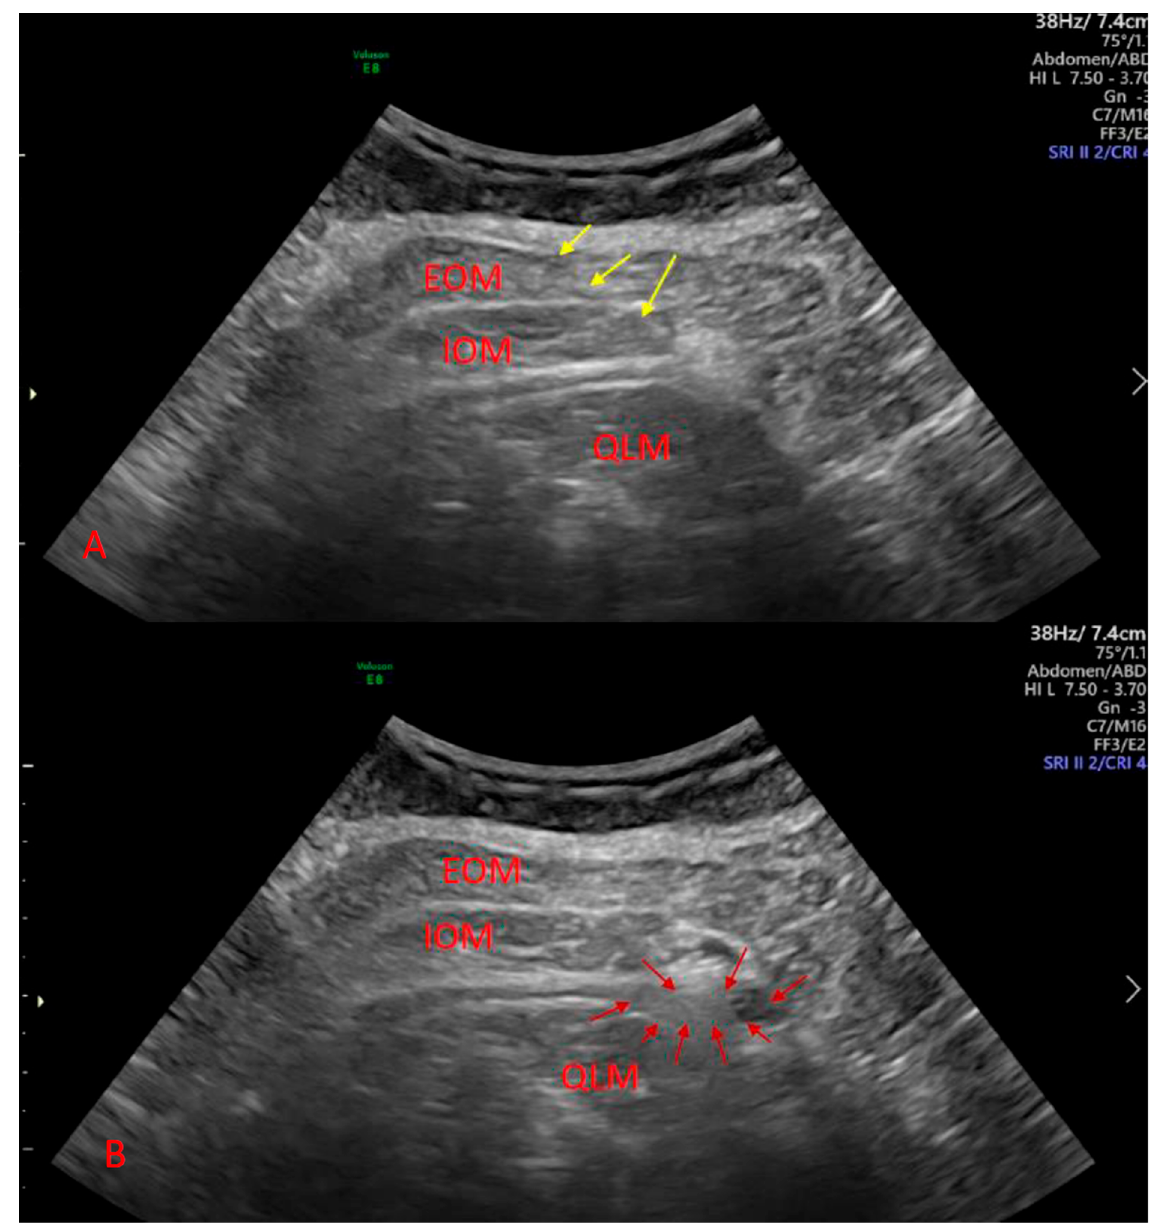
Figure 1. Ultrasound-guided quadratus lumborum block. Sonographic image of quadratus lumborum block before (A) and after (B) local anes- thetic deposition. Yellow arrows denote needle shaft, and red arrows denote local anesthetic. EOM denotes external oblique muscle, IOM denotes internal oblique muscle, and QLM denotes quadratus lumborum